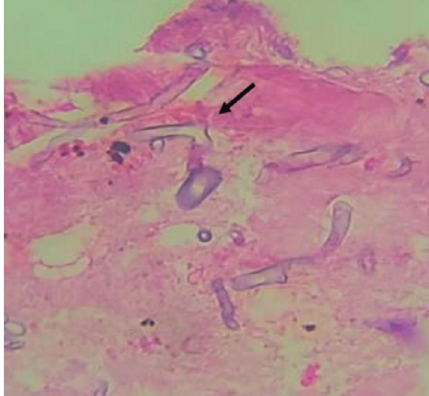
Figure 2: Histopathology showing broad, nonseptate hyphae with 90-degree angle branching (hematoxylin and eosin staining, original magnification ×